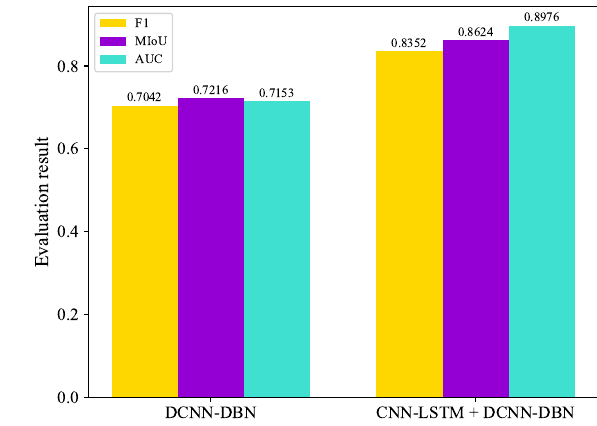
Figure 7. Evaluation results of the two groups of